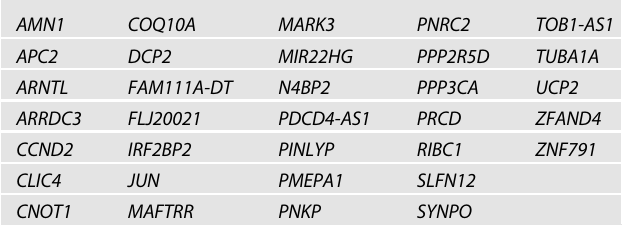
Fig. 3 Integrative analysis data identi fi es novel RFX7 target genes. a Heatmap of RNA-seq data for established and novel direct RFX7 target genes that bind RFX7 within 5 kb from their TSS according to ChIP-seq data and are signi fi cantly (FDR < 0.01) down-regulated (log 2 FC ≤ – 0.25) in both Nutlin-3a-treated RFX7 knock-out U2OS cell lines compared with parental U2OS cells. Signi fi cant (FDR < 0.01) p53-dependent regulation is indicated at the left. b – d Genome browser images displaying RFX7 ChIP-seq signals and predicted X-boxes at the ( b ) MAFTRR , ( c ) ARRDC3 , and ( d ) FAM111A-DT gene loci. Table 1. 33 Novel direct RFX7 target